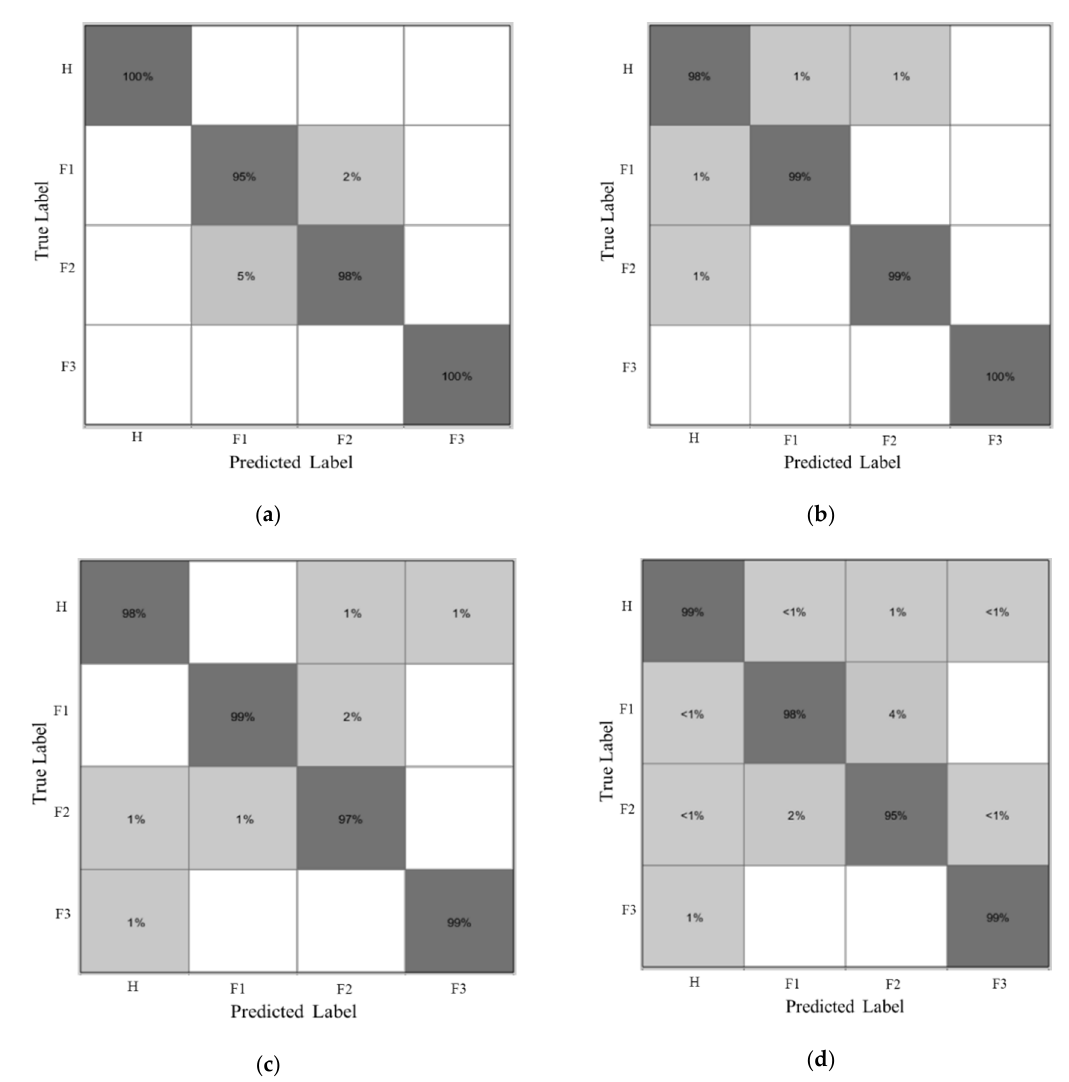
Figure 16. Confusion matrixes for four classification cases according to the speed dataset input for training: ( a ) 300 RPM, ( b ) 600 RPM, ( c ) 900 RPM, ( d ) 1200